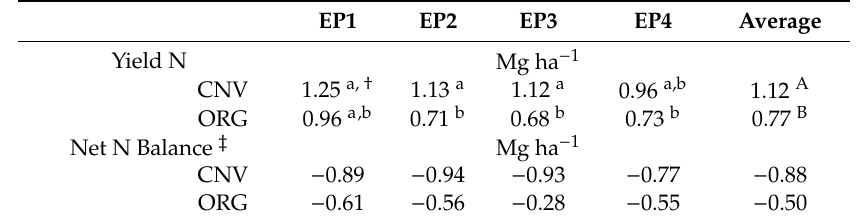
Table 6. Cumulative yield N and net N balance over 2002–2009 within the conventional (CNV) and organic (ORG) systems by entry point (EP) into the rotation.